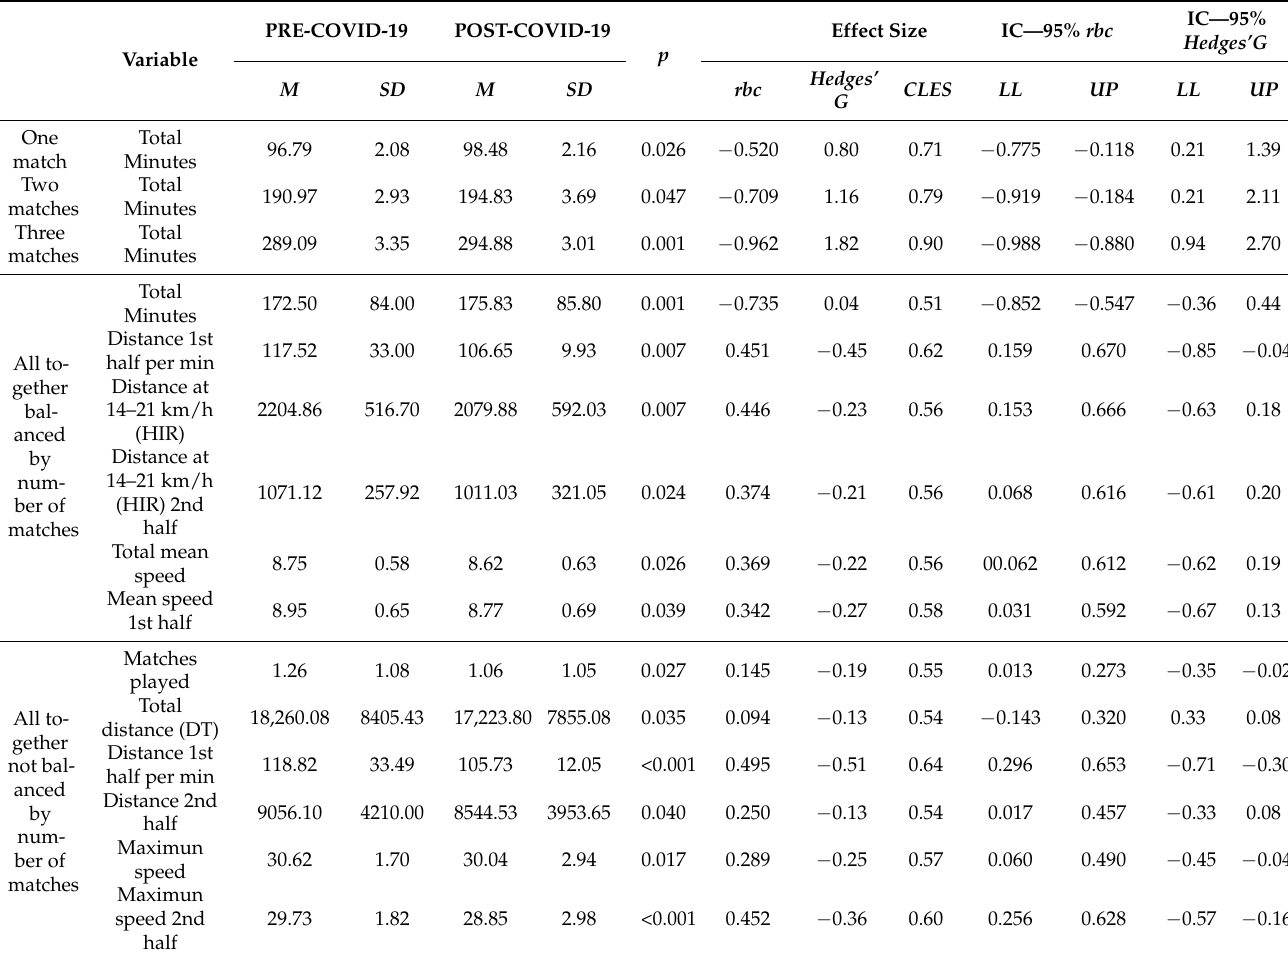
Table 2. Comparisons of pre- and post-isolation periods by number of